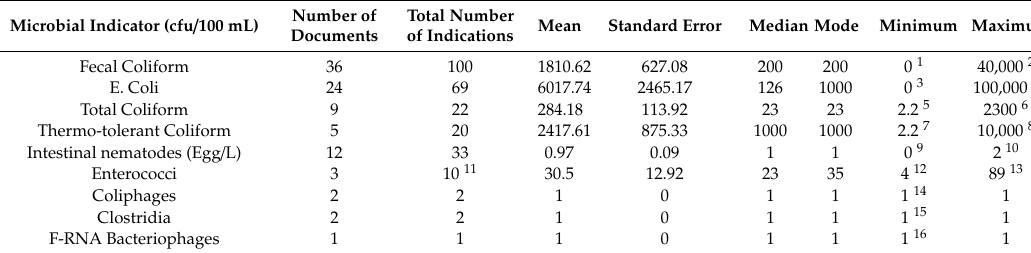
Table 6. Descriptive statistical analysis of common pathogen indicators included in agricultural water reuse regulations and